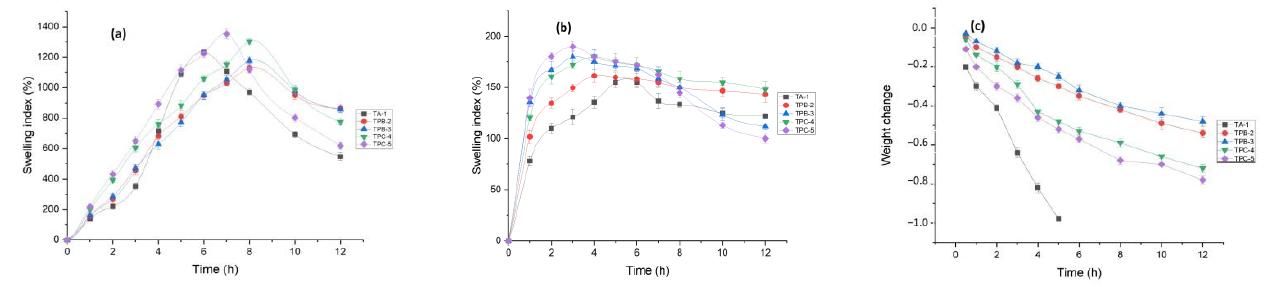
Figure 6. Swelling index (%) of TRHC-PAG-alginate microspheres: ( a ) pH 1.2; ( b ) pH 7.4; ( c ) weight change in pH 7.4 (Mean ± SD, n = 3).